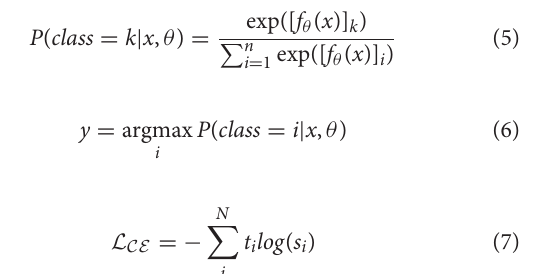
and the slope sign change feature ssc ( x a ... b